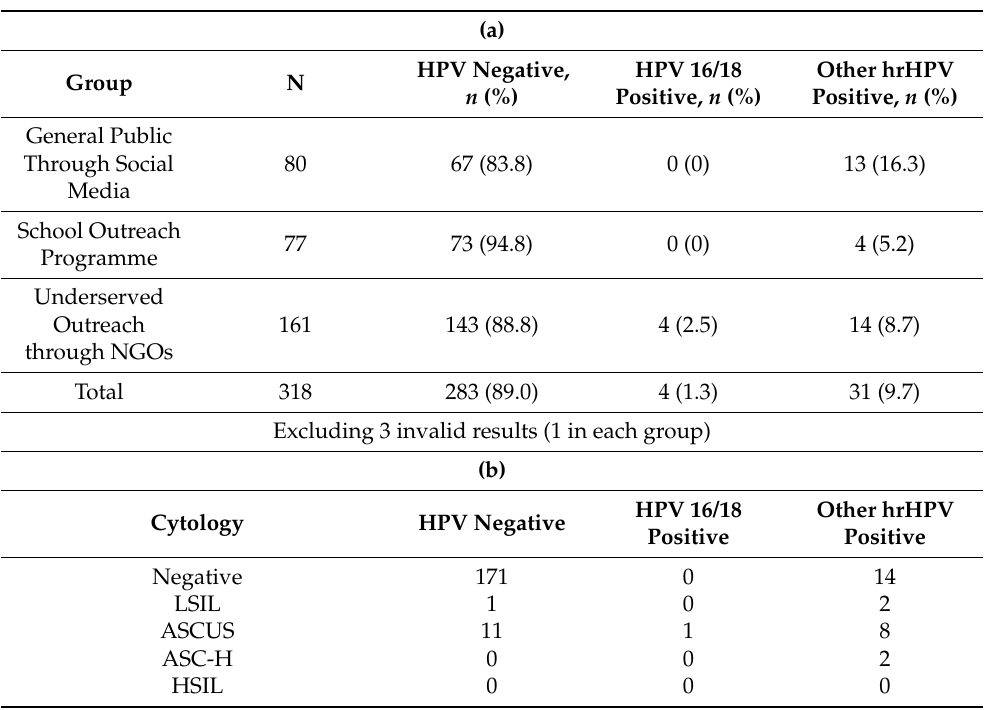
Table 3. ( a ) Self-sampling HPV results. ( b ) Co-test results (N = 210).